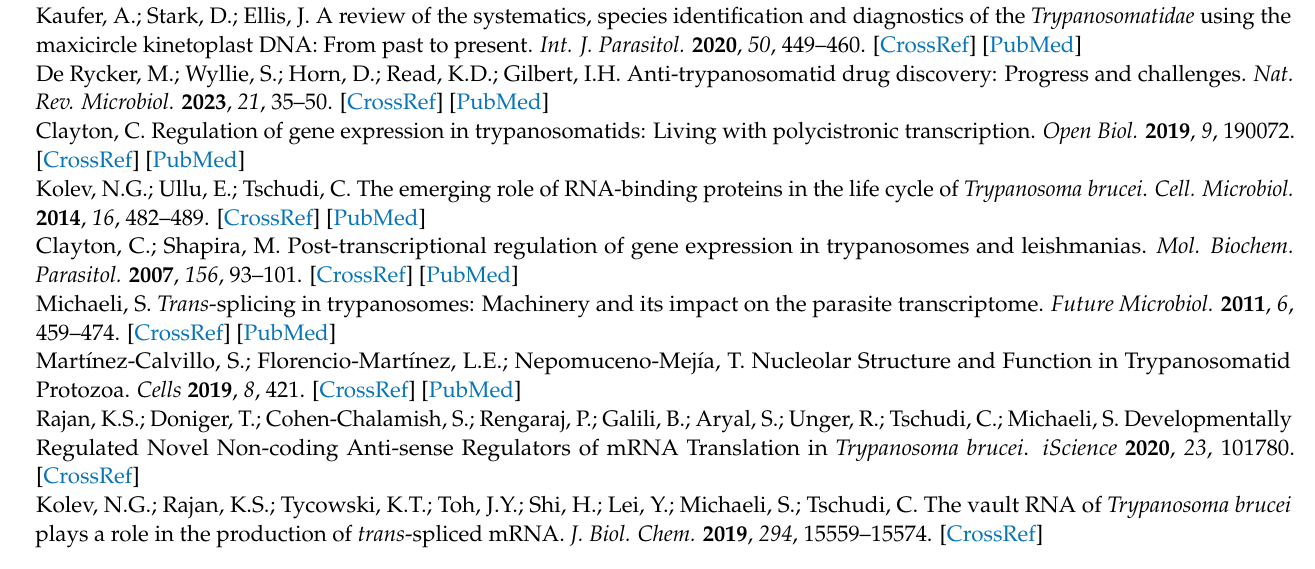
Figure S7: Noncoding RNAs as precursors for snoRNAs. Figure S8: Sequence and structure compari- son of coding and noncoding T. brucei transcripts. Figure S9: Complex clustering of lncRNA genes. Figure S10: Genomic context and differential expression of 4 newly identified T. brucei lncRNAs. Figure S11: Transcript coverage and A-nt content of the variable region of the T. brucei mitochondrial (maxicircle) genome. Figure S12: DRS-derived steady-state levels of mitochondrial transcripts in procyclic-stage and bloodstream-stage T. brucei . Figure S13: Polyadenylation analysis of T. brucei mitochondrial RNAs. Supplementary Tables—Table S1: Read statistics of DRS sequencing data. Table S2: Transcript mapping statistics. Table S3: Identification of full-length sequencing reads. Table S4: Performance of lncRNA prediction tools. Table S5: Genomic locations of novel intergenic lncRNAs. Table S6: Differential gene expression. Genes up-regulated in bloodstream-stage T. brucei . Table S7: Differential gene expression. Genes up-regulated in procyclic-stage T. brucei